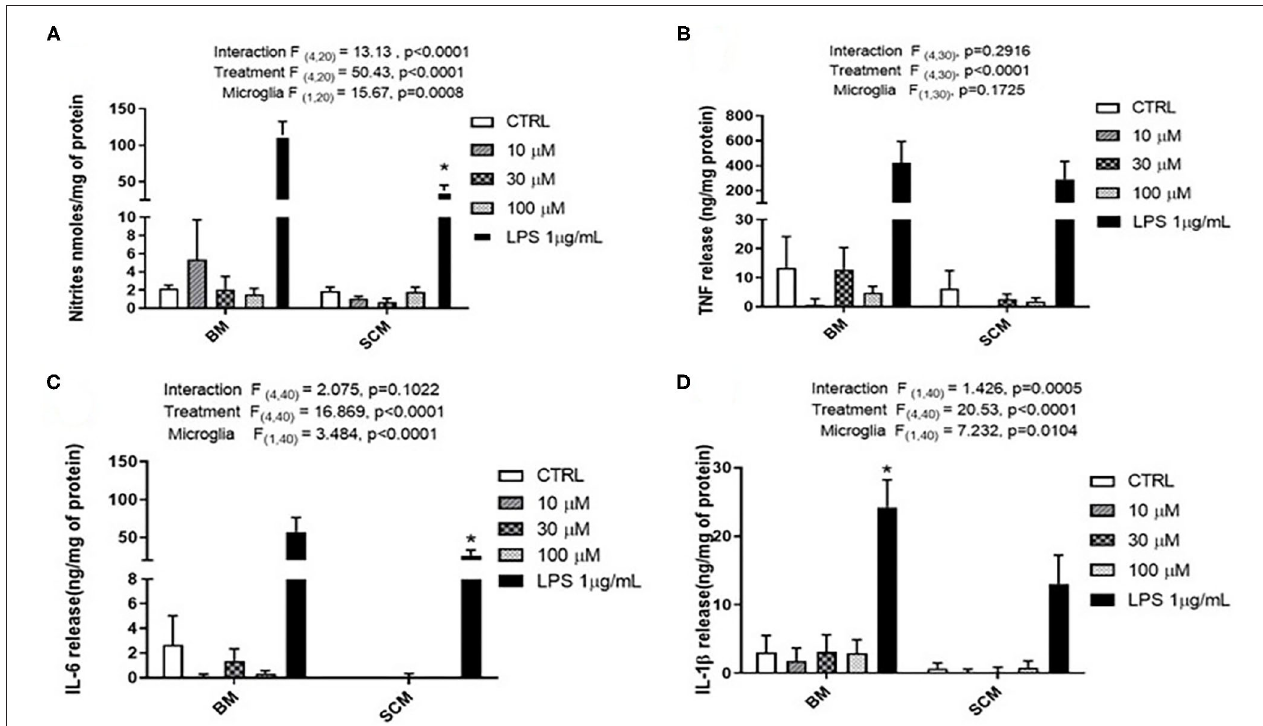
FIGURE 2 | Release of the pro-inflammatory effector by BM and SCM exposed to glutamate. (A) Two-way ANOVA identified significant interaction between microglia and treatment for NO. There was also a significant main effect of microglia and treatment, n = 3 (where n represent the number of independent experiments i.e., separate microglia preparations). (B,C) Two-way ANOVA revealed a significant main effect for glutamate treatment for TNF. n = 4 for TNF and n = 5 for IL-6. (D) Two-way ANOVA revealed a significant main effect for microglia and treatment ( n = 5). * represents p < 0.05a significant difference between respective LPS treatments revealed by the Sidak post-hoc test. Bars represent mean ± s.e.m.